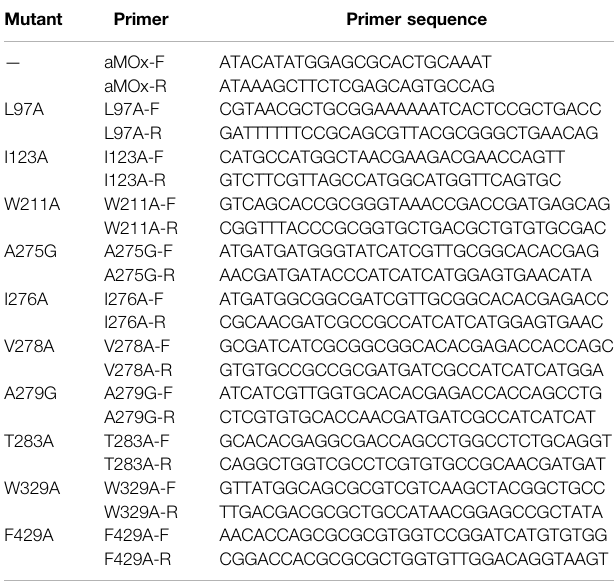
TABLE 2 | Primers used for the construction of aMOx variants.